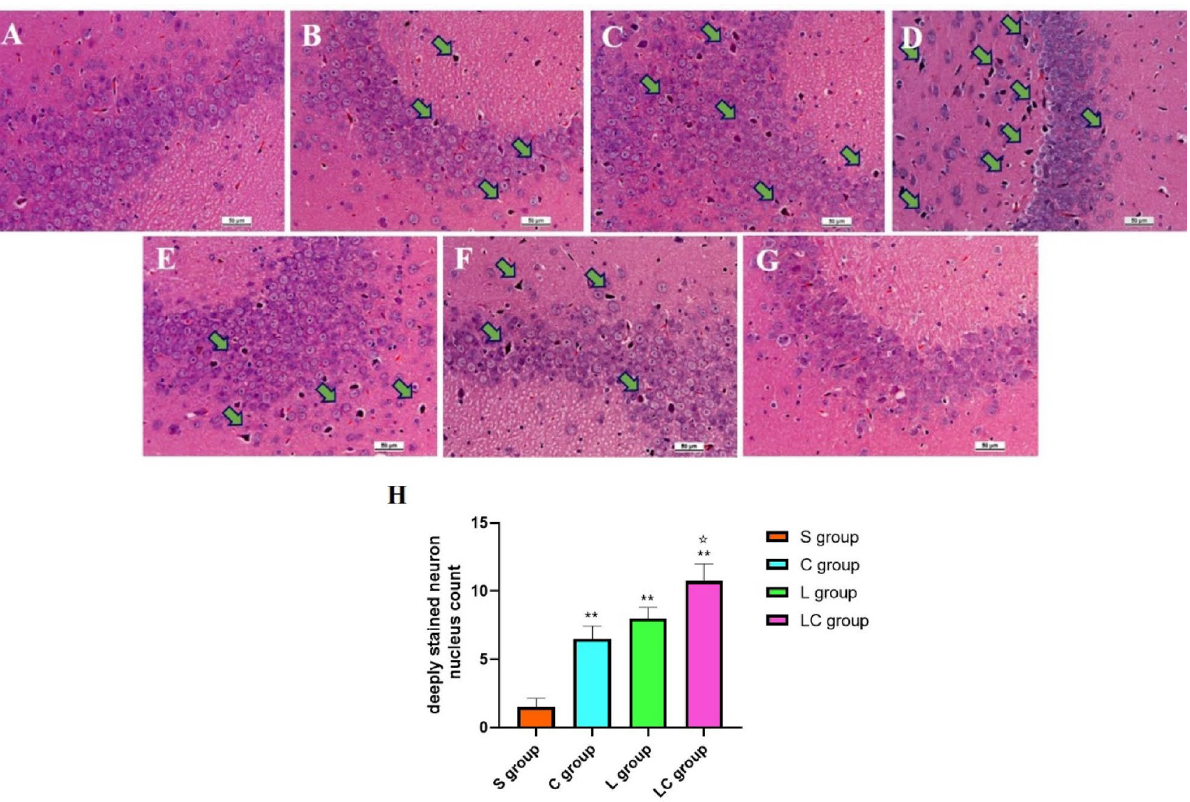
Figure 3. Microstructural pathological injuries in hippocampal tissue of rats at 7 days after 1.5-GHz and 4.3- GHz microwave irradiation (scale bar = 50 μm), ( A ) S group, no degeneration of the neuron nucleus. ( B – D ) In the C10 group, L10 group and LC10 group, respectively, neuron nucleus deep staining occurred. ( E – G ) Injuries of the LC10 group rats at 1 day, 14 days and 28 days after irradiation, neuron nucleus deep staining. The green arrows in the figure show deep neuronal staining. ( H ) Count of deeply stained neuron nucleus in hippocampus of rats in S, C, L and LC groups. Quantized data were shown as mean ± SE. *P < 0.05, **P < 0.01, vs. sham, ✩ P < 0.05, LC10 vs. C10. H was drawn by Graph Pad Prism 6 and the data were analyzed by SPSS